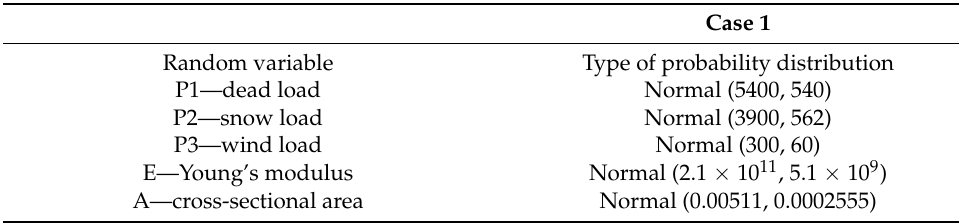
Table 3. Description of random variables for Case 1.